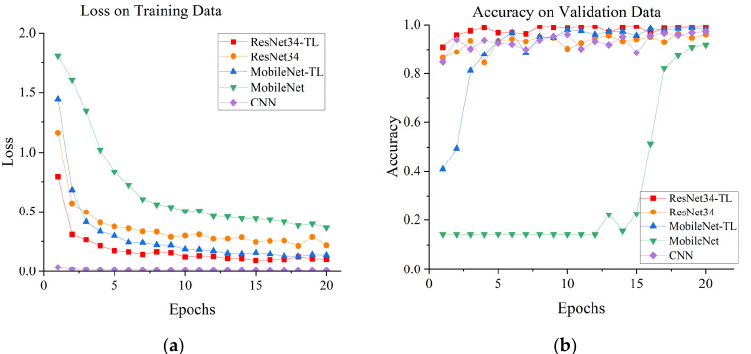
Figure 9. Experimental results for all models: ( a ) training set loss; ( b ) validation set accuracy.